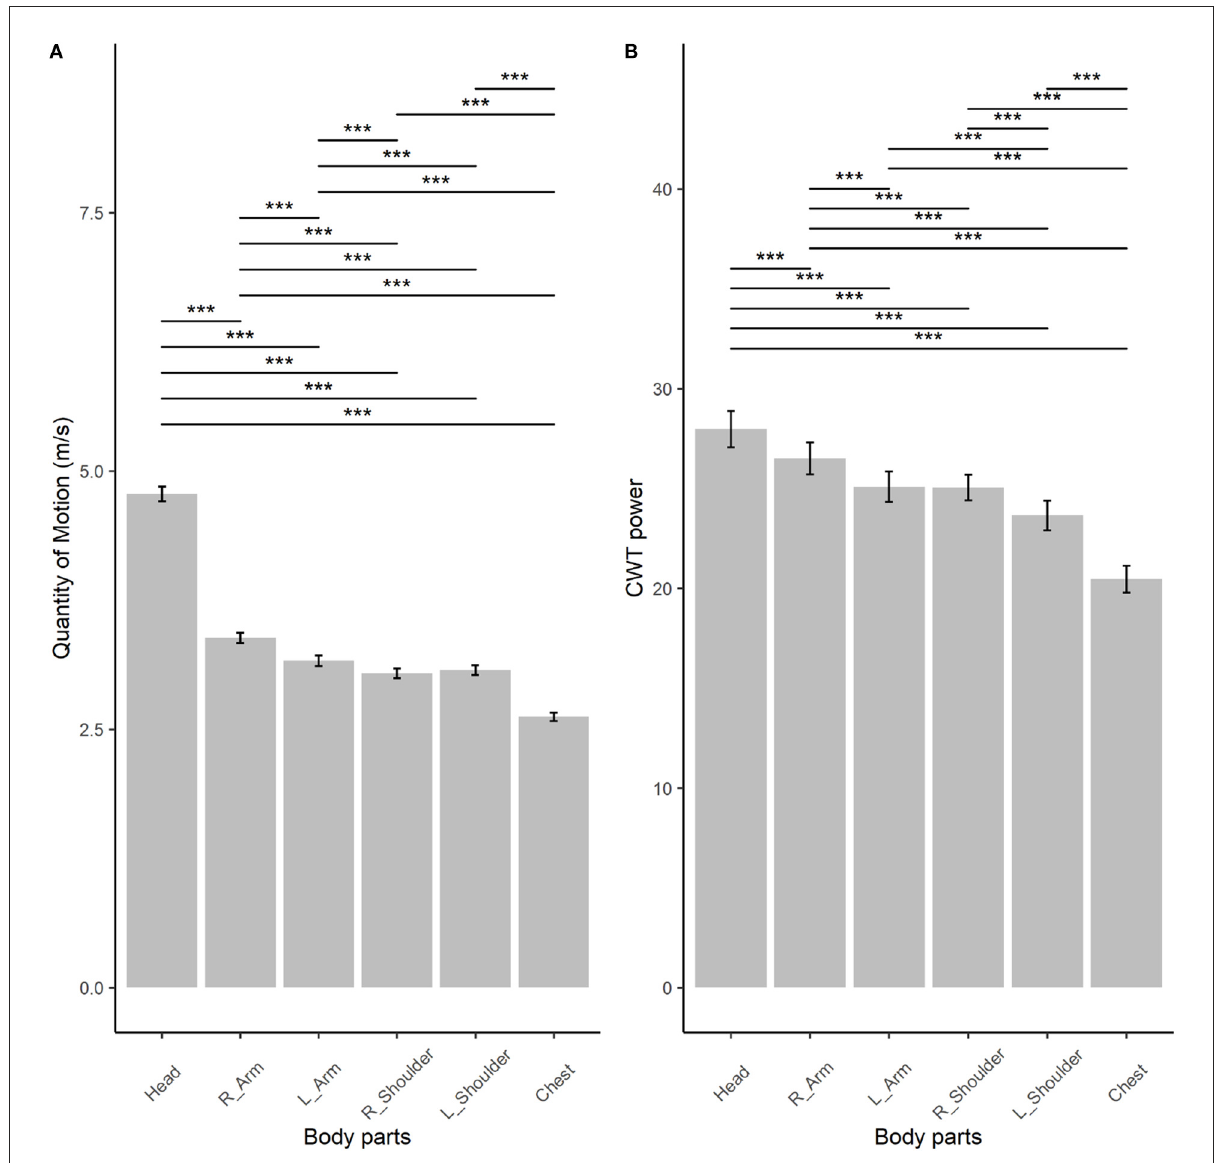
FIGURE4 Quantity of motion (QoM, A ) and cross-wavelet transforms (CWT, B ) power by body parts (i.e., head, right and left arm [R_Arm and L_Arm] and shoulder [R_Shoulder and L_Shoulder], and chest), based on linear mixed modeling. Error bars represent 95% CI of the mean. P -values were adjusted using the Tukey post-hoc tests. ∗∗∗ p <